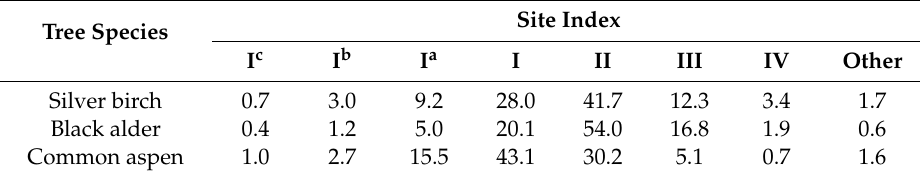
Table 3. Distribution of area of studied tree species by site